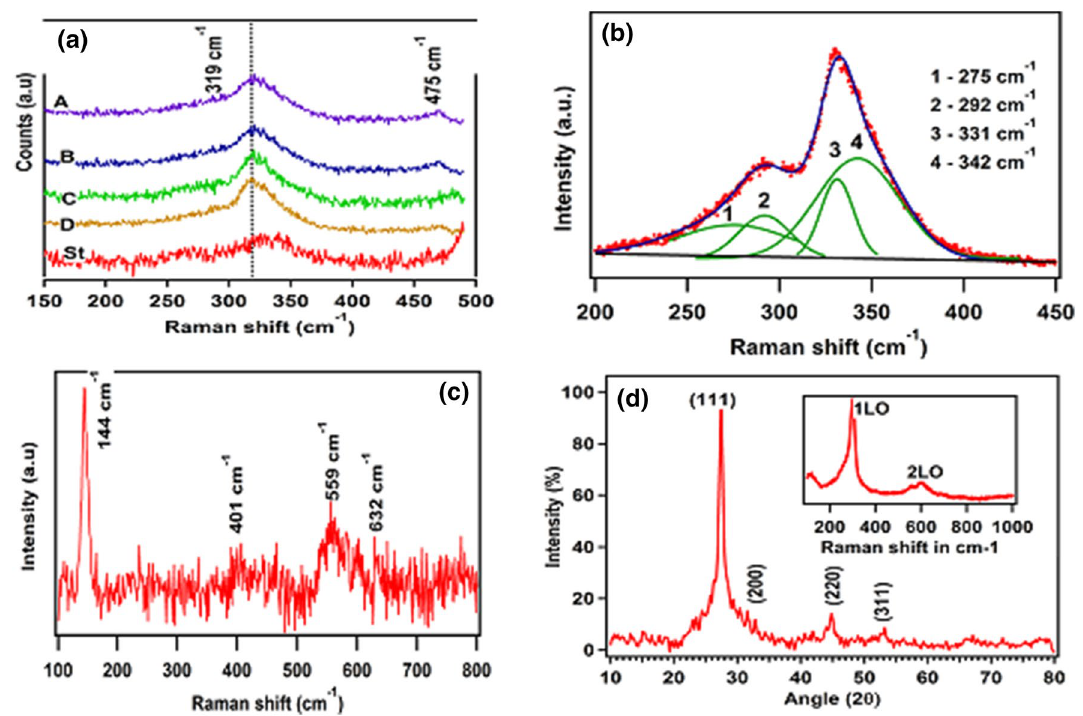
Fig. 2 a Raman spectra of the films deposited using single cationic bath. b Raman spectrum of CZTS film deposited by SILAR with augmented Zn adsorption. c Raman spectrum of compact TiO 2 film. d XRD pattern of CdS film and Raman spectrum as